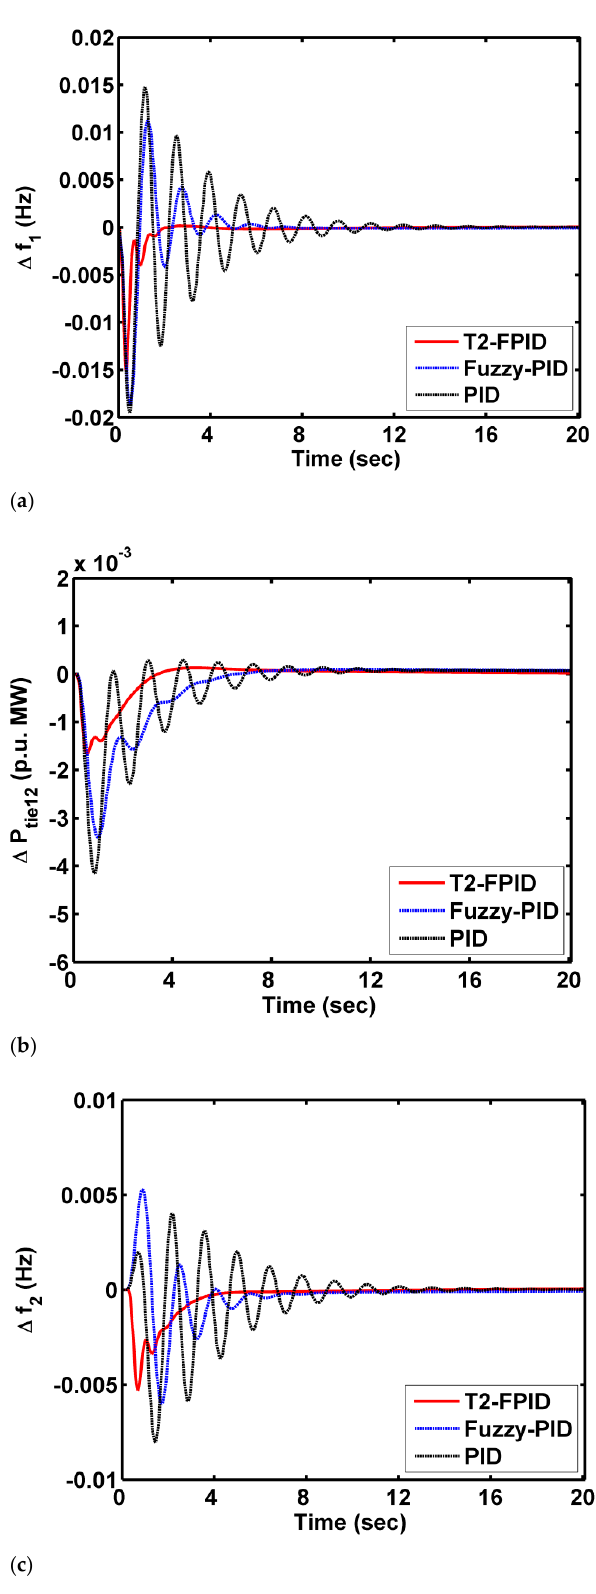
Figure 8. Responses for case 2: ( a ) Δ f 1 ( b ) Δ P tie12 and ( c ) Δ f 2 .